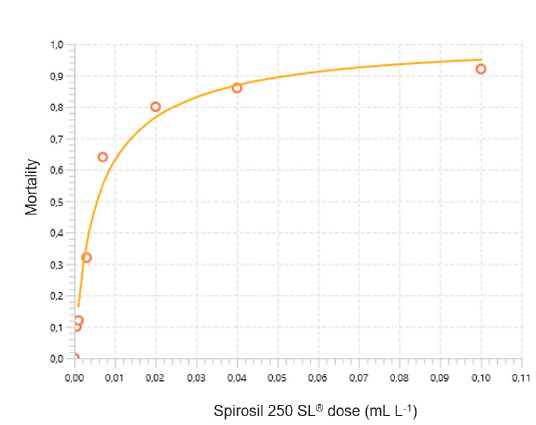
Figure 1. Dose/mortality regression curve of Spirodiclofen over the susceptible reference line T. urticae Table 4: Mortality (%) of four field populations of T. urticae due to LC50 of Spirodiclofen (0.0056 mL.L−1) obtained for the susceptible reference line. Population n Mortality (%) Significance S.E.